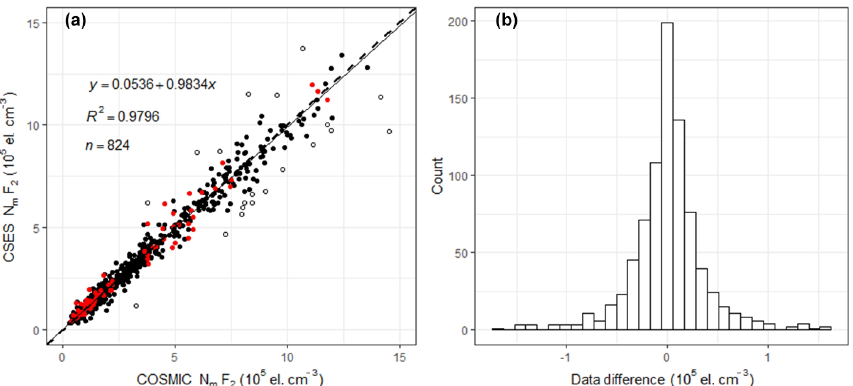
Figure 4. Scatter plot of matched Nm F2s and histogram of the data differences between the two sets. The dashed line in (a) is the equal value line with a slope of 1, and the solid line is the linear fitting line. Open circles are points exceeding 3 times the RMSE. Red solid points are data observed when Dst < − 30nT. y refers to CSES Nm F2 data, x COSMIC Nm F2 data. R 2 is the goodness-of-fit coefficient; n is the total data number after eliminating